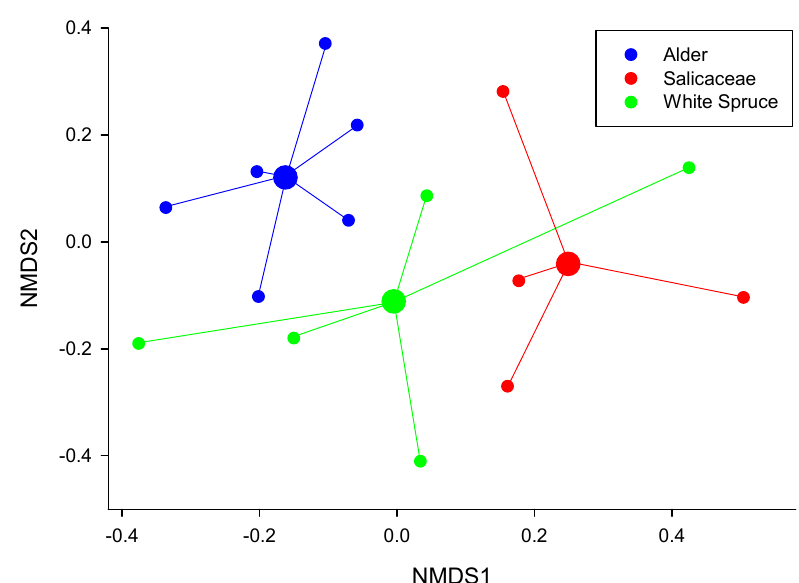
Figure 4. Spider plot of ectomycorrhizal fungi (EMF) community composition derived from non ‐ metric dimensional scaling ordination and PERMANOVA comparisons ( pairwiseAdonis package) based on a dissimilarity matrix of species abundance data which showed that alder root ‐ tip communities were significantly different from both white spruce ( p < 0.05) and Salicaceae ( p < 0.10). Species clusters identify the centroid (spatial mean) of data points representing combinations of successional stage and horizon for each host.